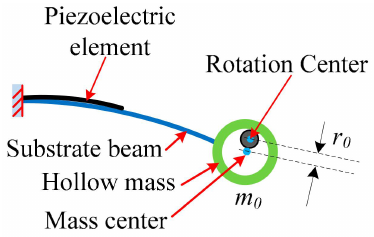
Figure 2. Schematic of the designed cantilever beam with hollow